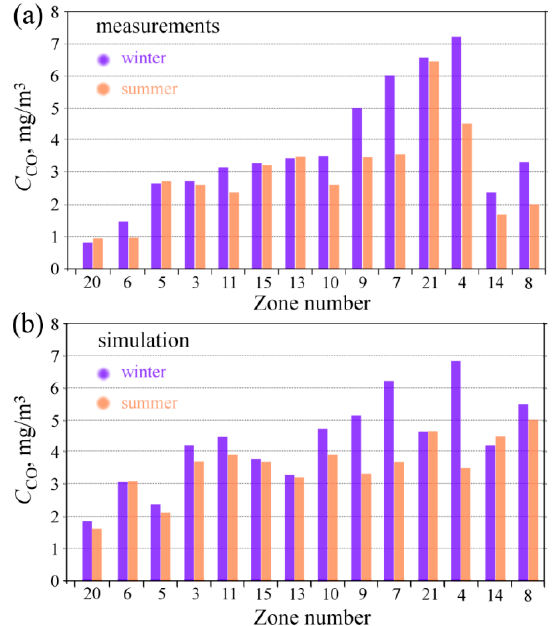
Figure 17. Comparison of the measured [1] and simulated CO concentrations (averaged over a day) at various locations in the city (indicated in Figure 1). Blue. Winter; orange, summer. ( a ) Measurements; ( b ) Simulation (at 10 m altitude). Zone numbers from Figure 1.